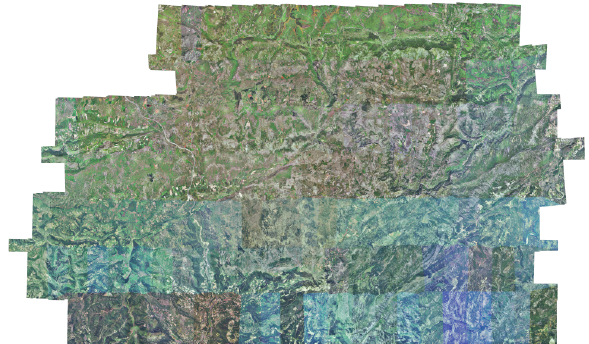
Figure 11. Orthophotomosaic with basic Wallis filtering correction using optimal window size ( 9% ).